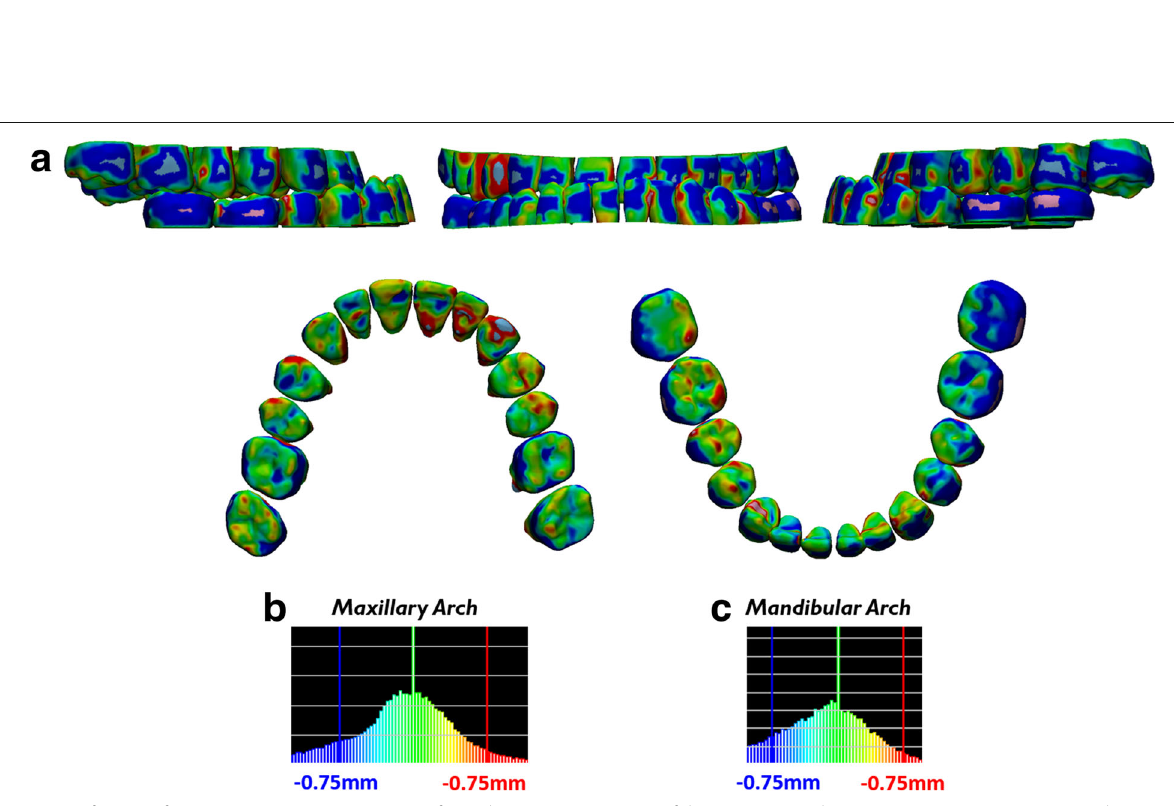
Fig. 7 Verification of accurate crown superimposition after indirect superimposition of the ERP setup and reset appointment CBCT scan. a Color displacement maps comparing the crown positions of the ERP setup and reset appointment CBCT scan. Green areas indicate 0.0 mm displacement; blue and red areas indicate equal to or greater than 0.75 mm. b , c Histograms showing the distribution of displacements between crowns of the ERP setup and reset appointment CBCT scan in the maxillary arch and mandibular arch